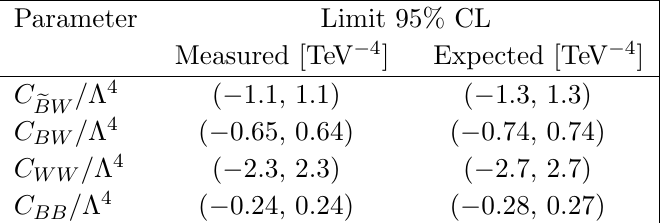
e BW = (cid:3) 4 , C BW = (cid:3) 4 , C WW = (cid:3) 4 or C BB = (cid:3) 4 . For e BW